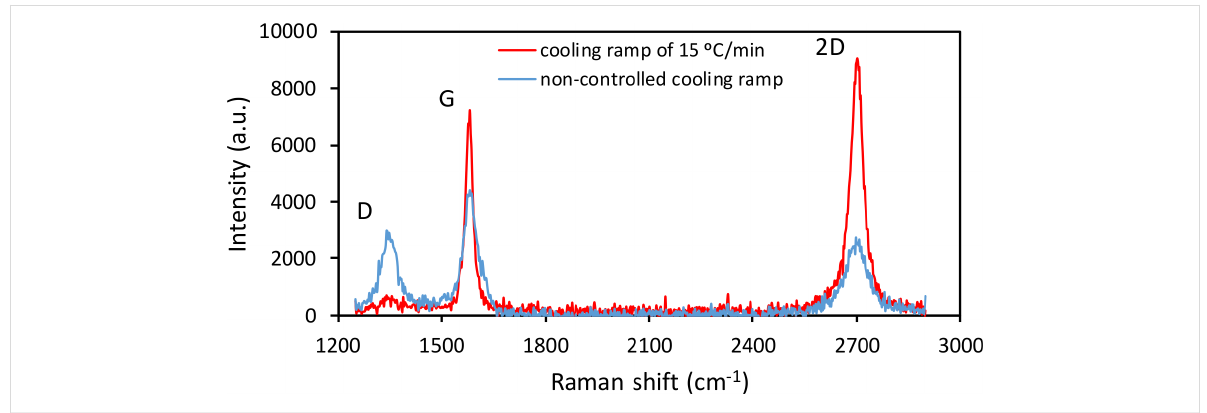
Figure 2: Typical Raman spectra of a graphene layer grown with an initial slow cooling rate of 15 °C/min and of a layer grown with non-controlled cooling rate. Note the low intensity of the defect band (D) in 1350 cm − 1 for the sample grown with slow cooling rate.